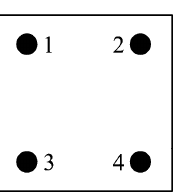
Figure 2. Measuring point layout of drying deformation.